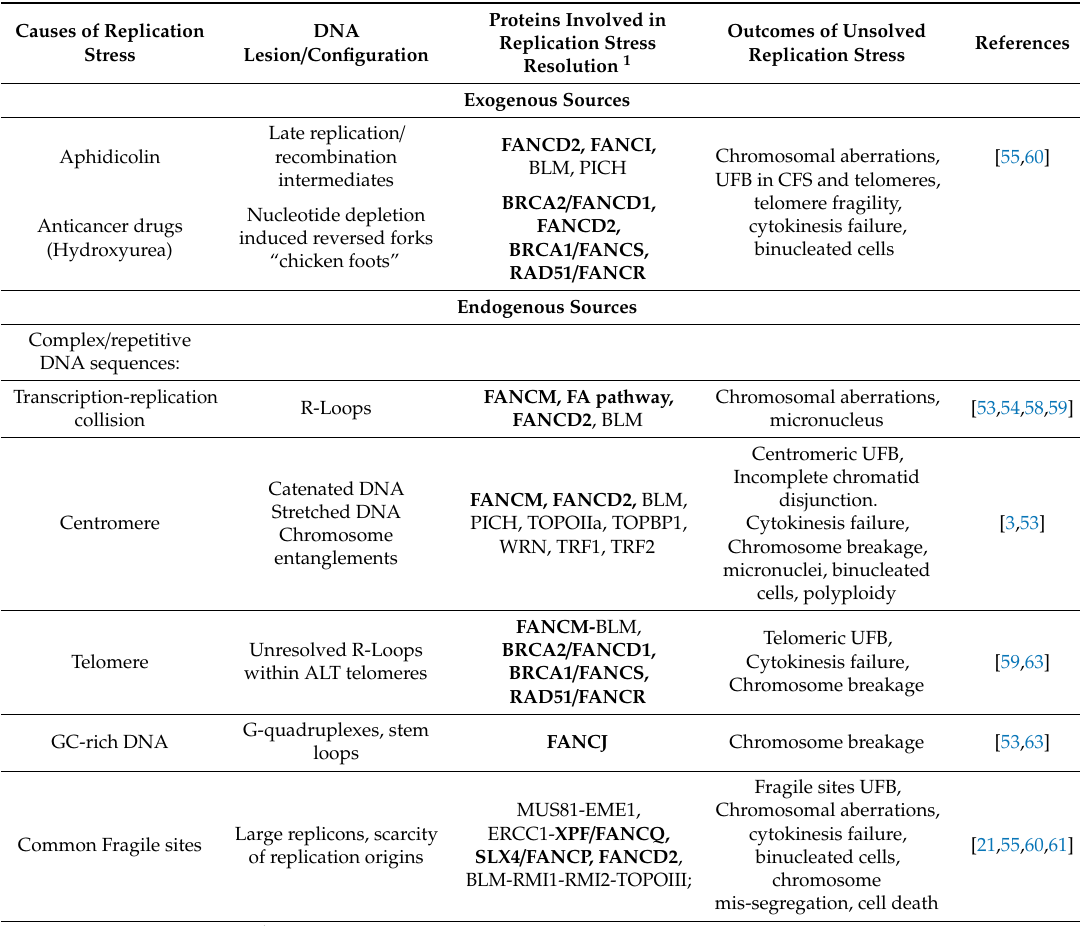
Participation of the FA / BRCA pathway in the resolution of replicative stress from diverse